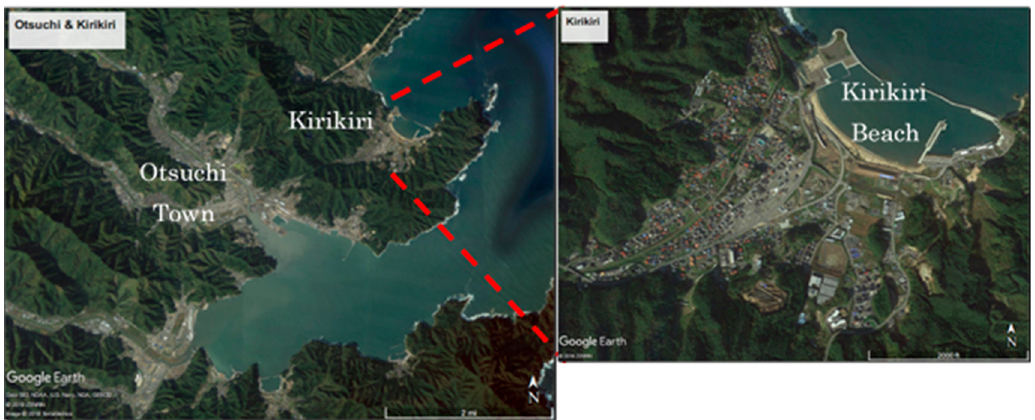
Figure 1. The Bay of Concepcion in Chile, showing the location of Dichato. Geosciences 2018 , 8 , x FOR PEER REVIEW